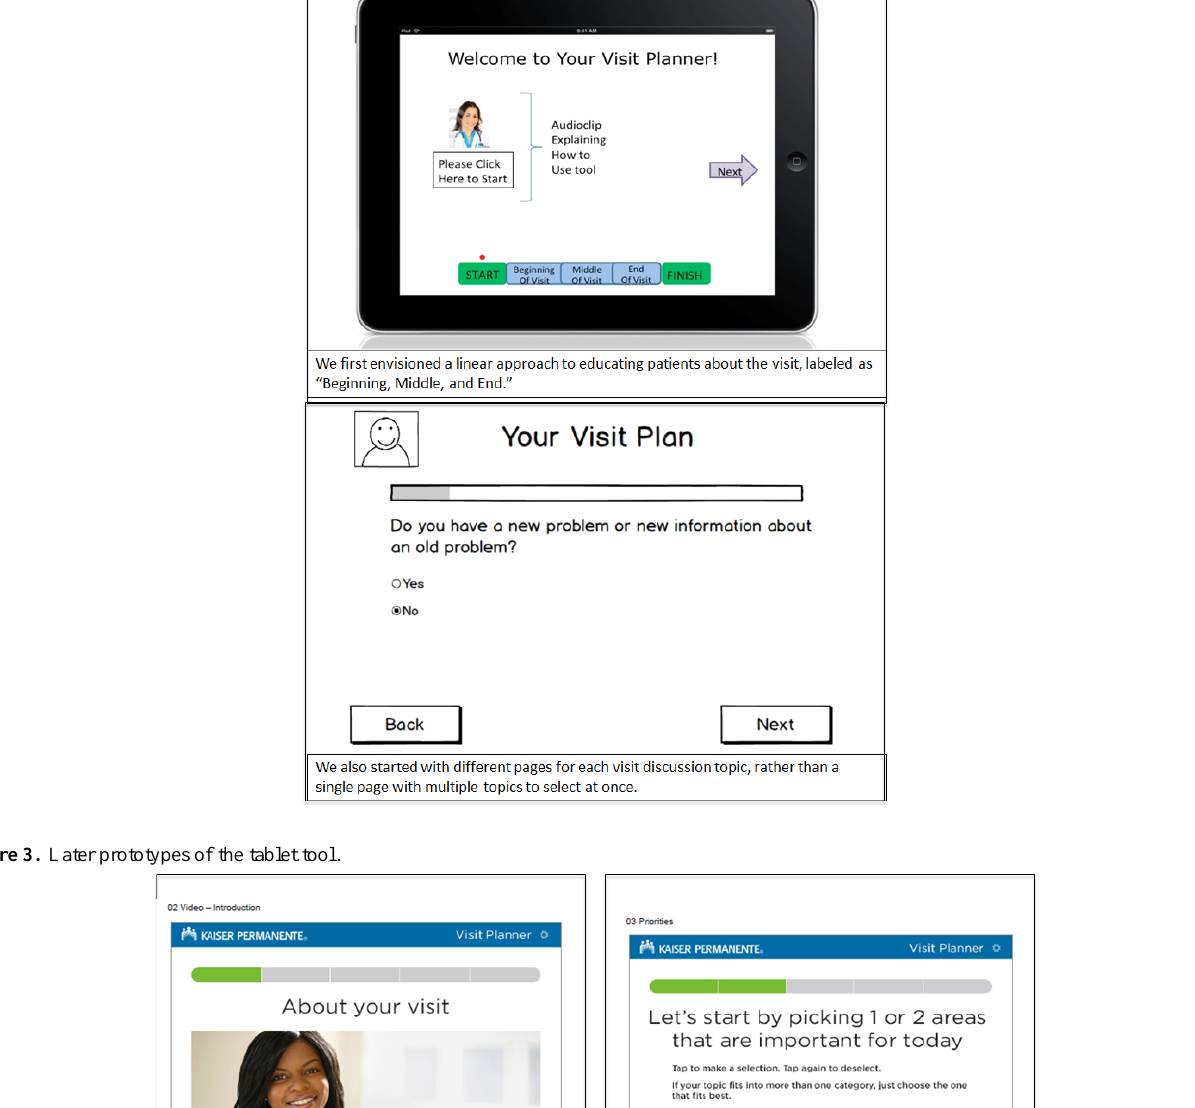
Figure 2. Early prototypes of the tablet tool.